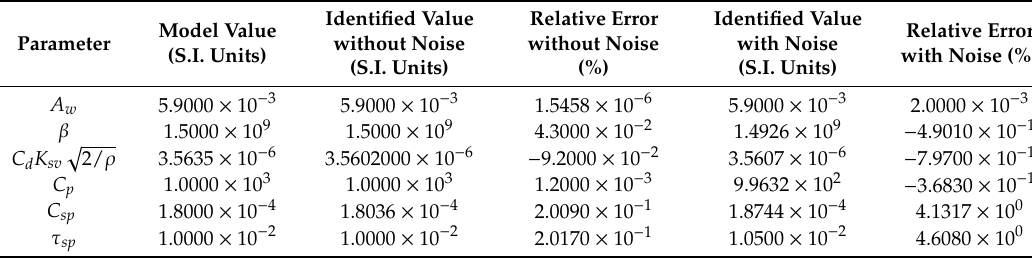
Table 2. Identified hydraulic parameters.